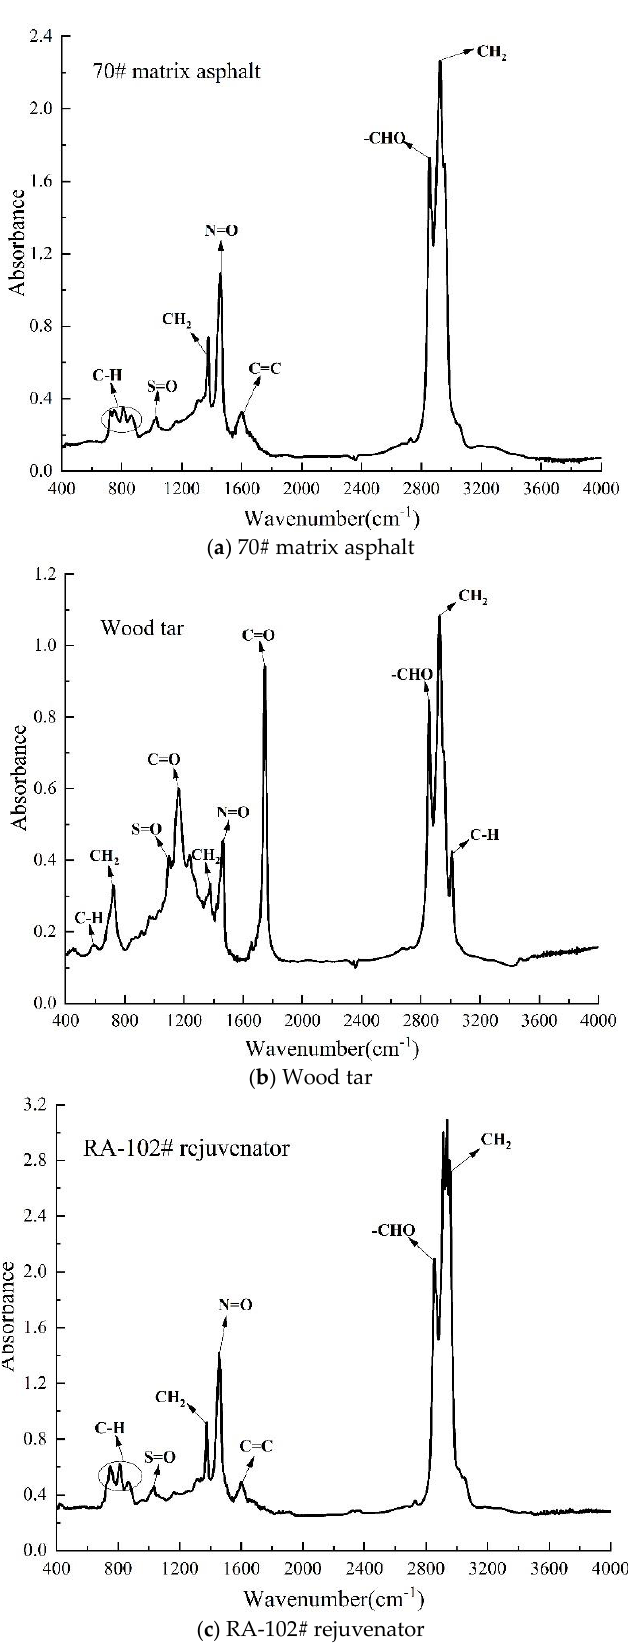
Figure 1. Infrared spectrum of each raw material ( a ) 70# matrix asphalt; ( b ) wood tar ; ( c ) RA-102# Figure rejuvenator.